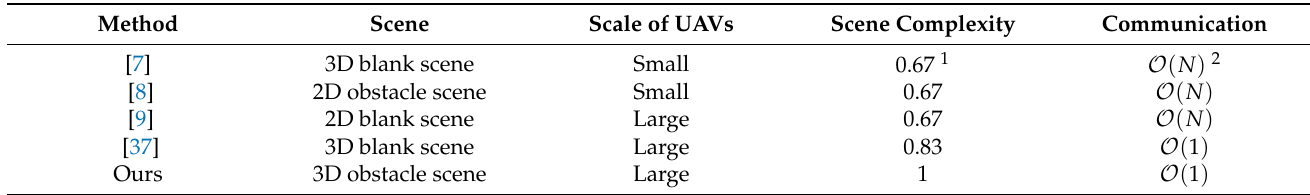
Table 1. Comparison with baseline methods for attack–defense